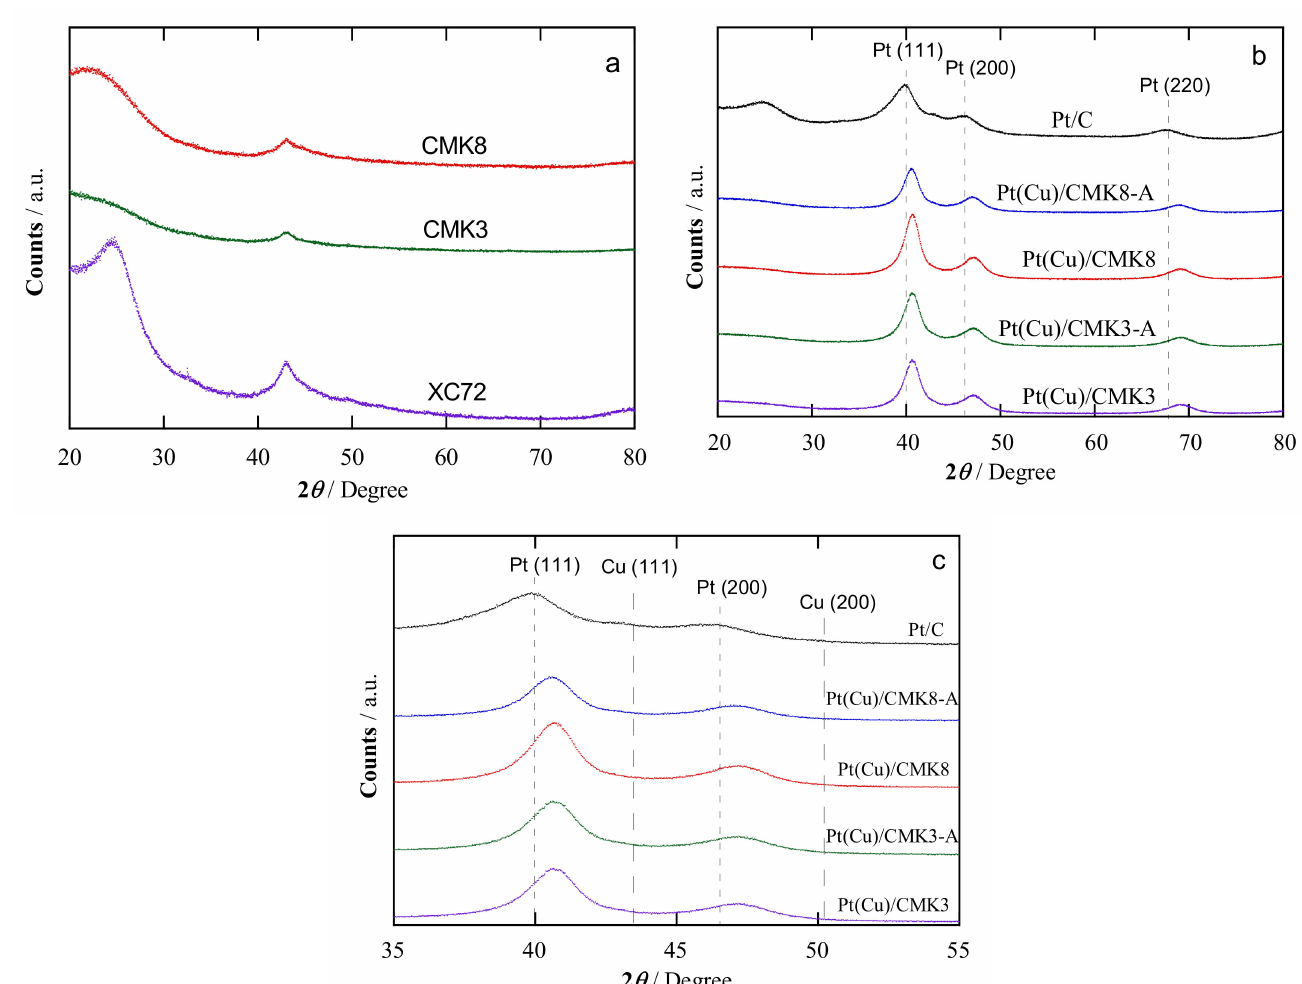
Figure 1. ( a ) XRD analyses of the supports and ( b ) of the supported Pt(Cu) catalysts. The region corresponding to Pt and Cu peaks (111) and (200) shown in plot ( b ) has been magnified in ( c ) to better show the peak location. The acronyms indicated refer to carbon black XC72, mesoporous carbons CMK3 and CMK8, and the activated mesoporous carbons CMK3-A and